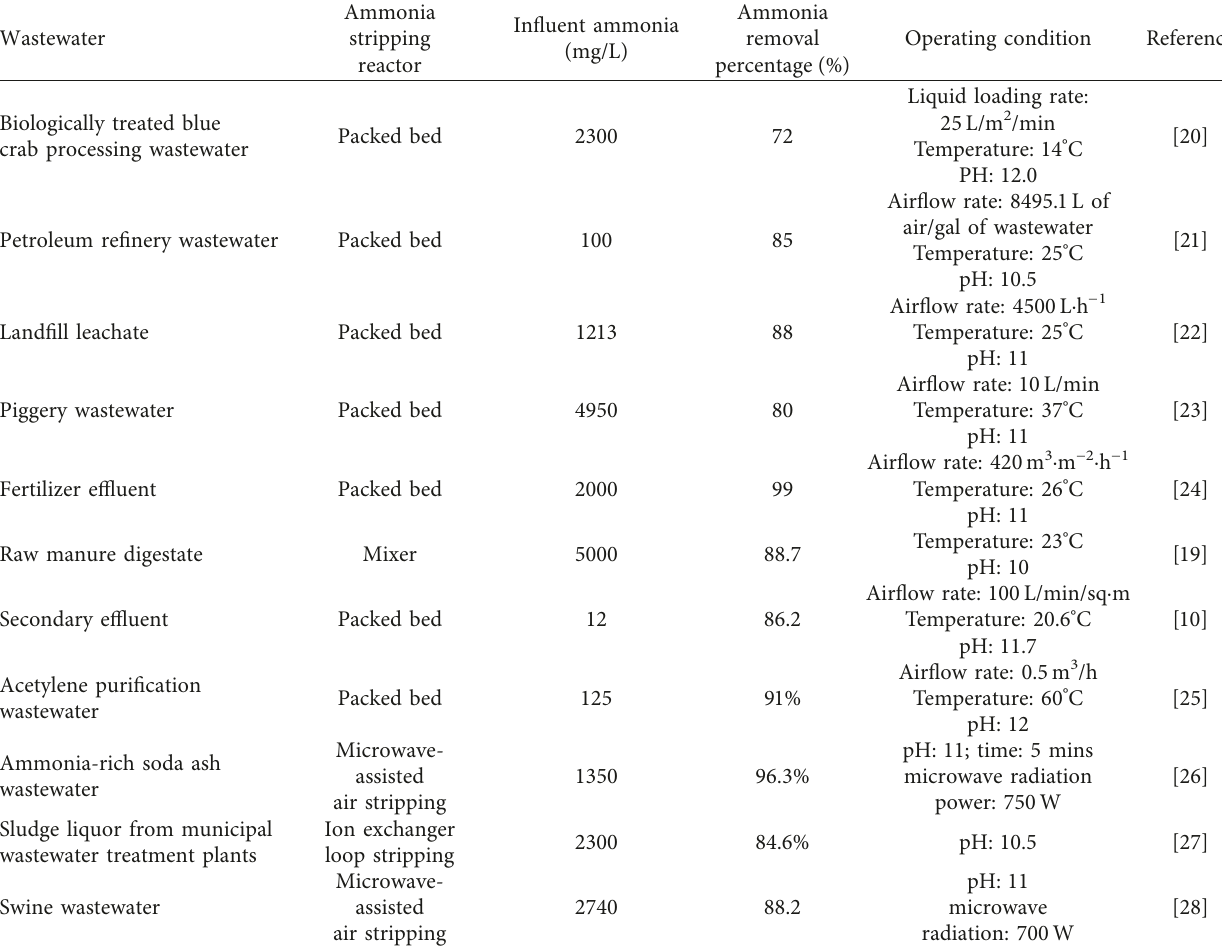
Table 1: Several studies that had looked into the ammonia stripping process with varied types of industrial wastewater.